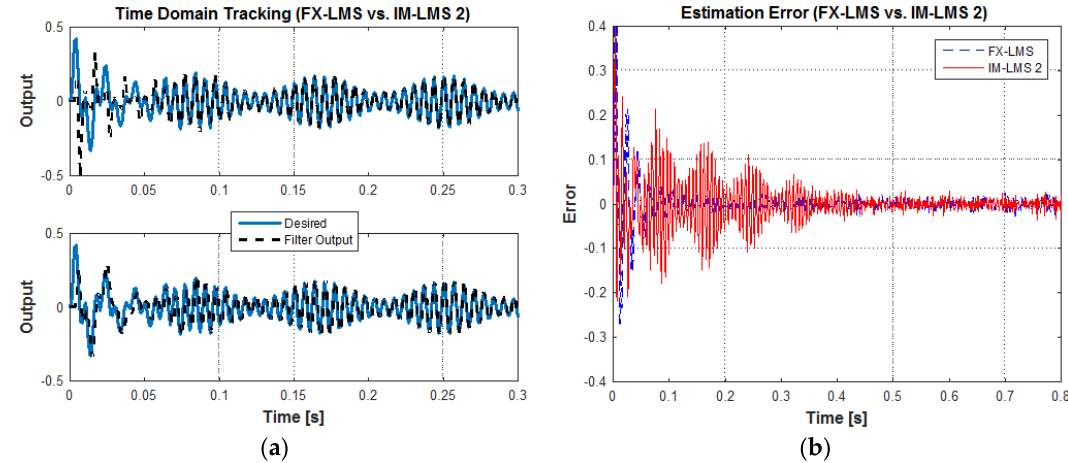
Figure 8. Control of an amplitude-modulated (AM) signal. ( a ) Time-domain tracking with LMS and internal model LMS 2 methods; ( b ) estimation error.